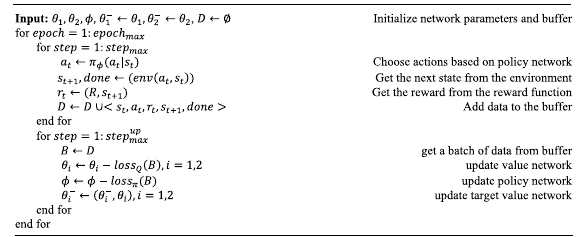
Algorithm 1. D-SAC algorithm.